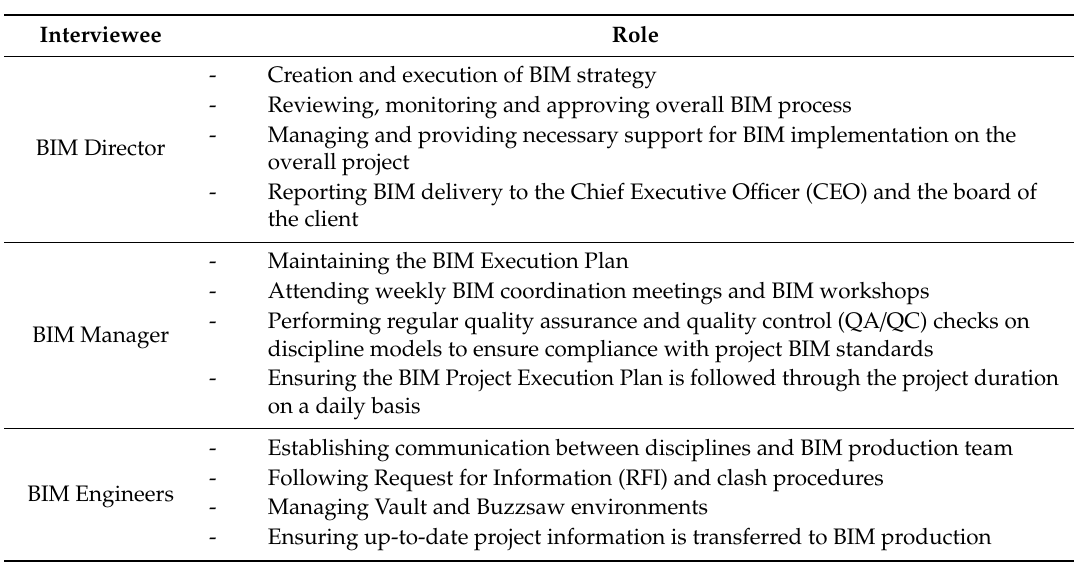
Table 2. Interviewees’ roles and responsibilities